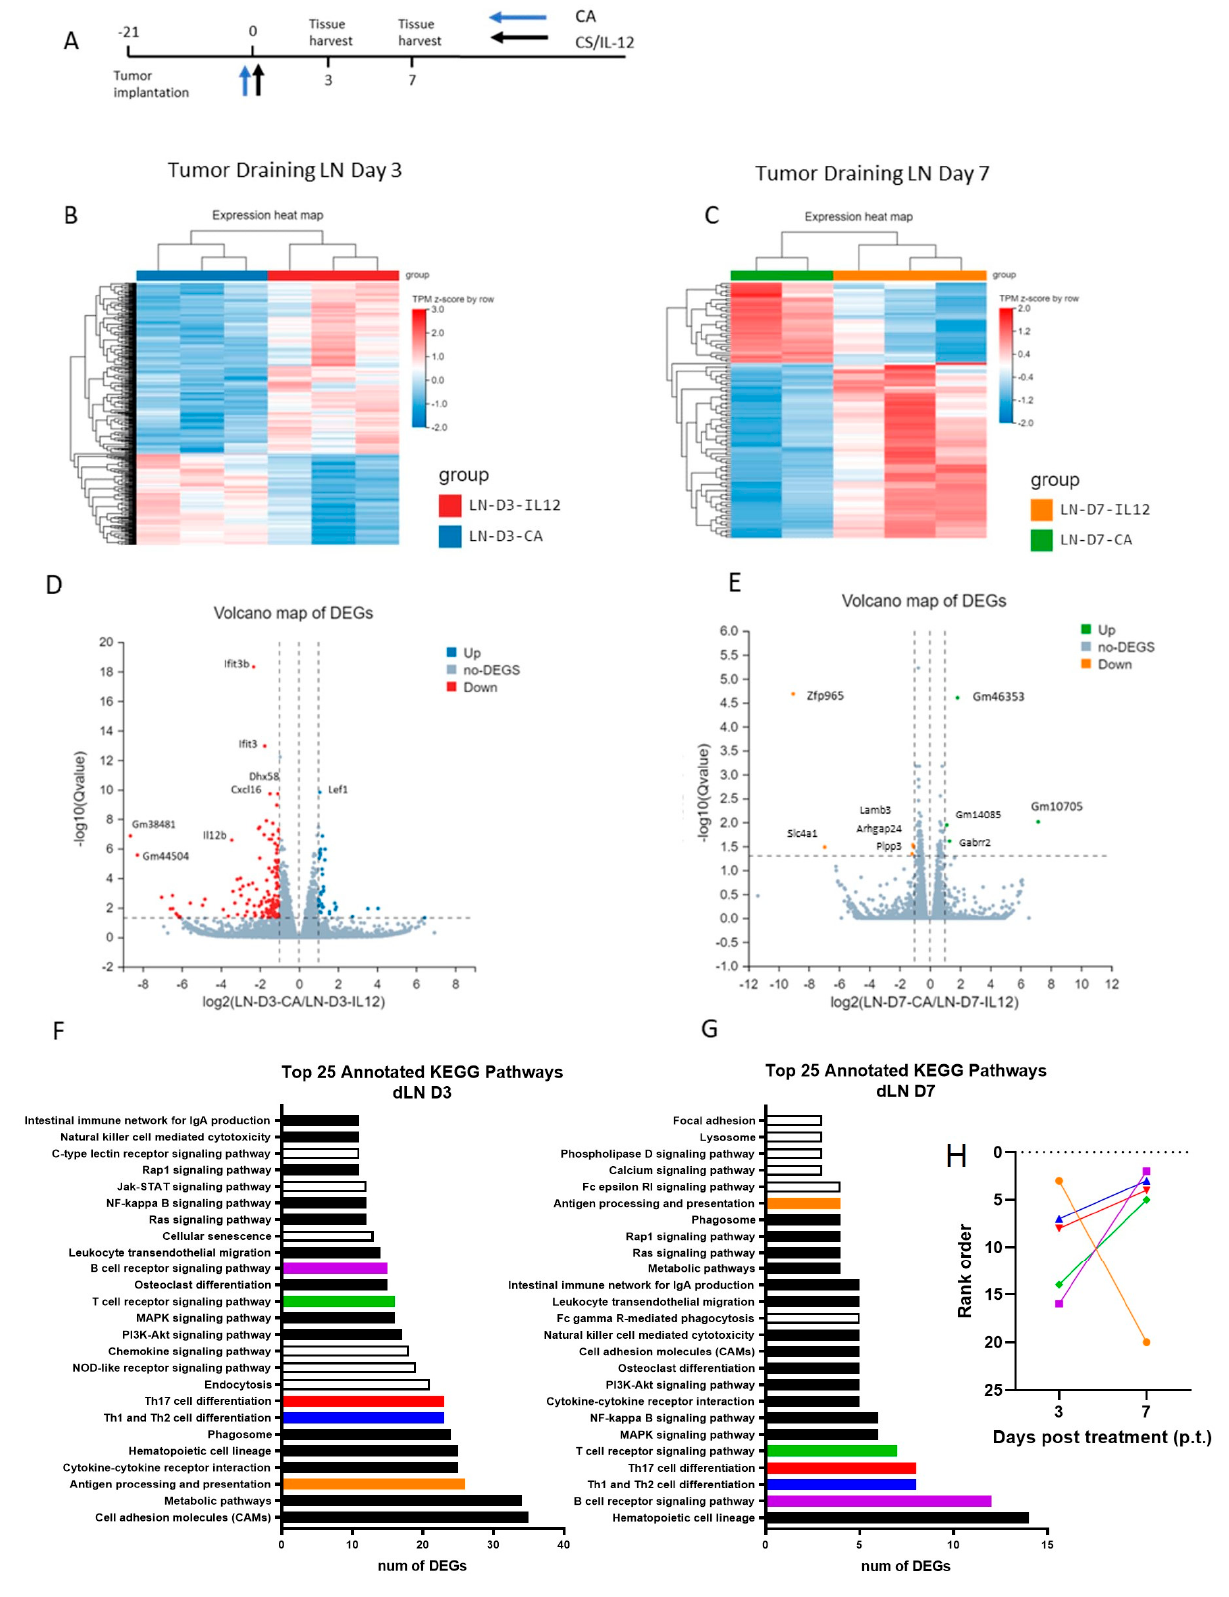
Figure 5. CS/IL-12 alters gene expression in the tumor draining lymph node. ( A ) C57BL/6 female mice were implanted with a single MC38 tumor and were treated with either CA alone or CA + CS/IL-12 and total RNA was extracted from the draining inguinal lymph node on day 3 ( B , D , F ) or day 7 ( C , E , G ) after treatment. All genes with Q < 0.05 were visualized with heatmaps for day 3 ( B ) and day 7 ( C ). Volcano plots, where the threshold for signi fi cant di ff erence was |log2FC| ≥ 1 and